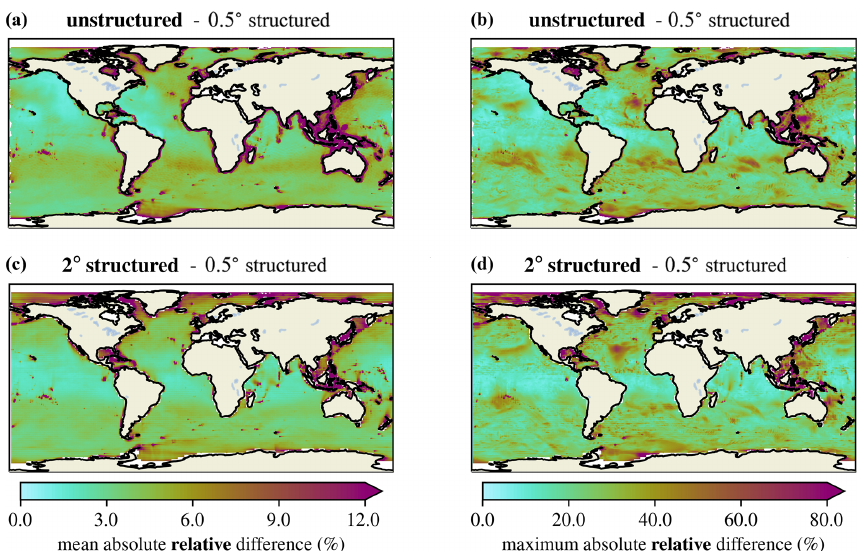
Figure 12. Mean (a, c) and maximum (b, d) absolute relative differences in significant wave height between the unstructured and 0.5 ◦ structured meshes (a, b) and the 2 and 0.5 ◦ structured meshes (c, d) . Note this is different from Fig. 11, which shows absolute